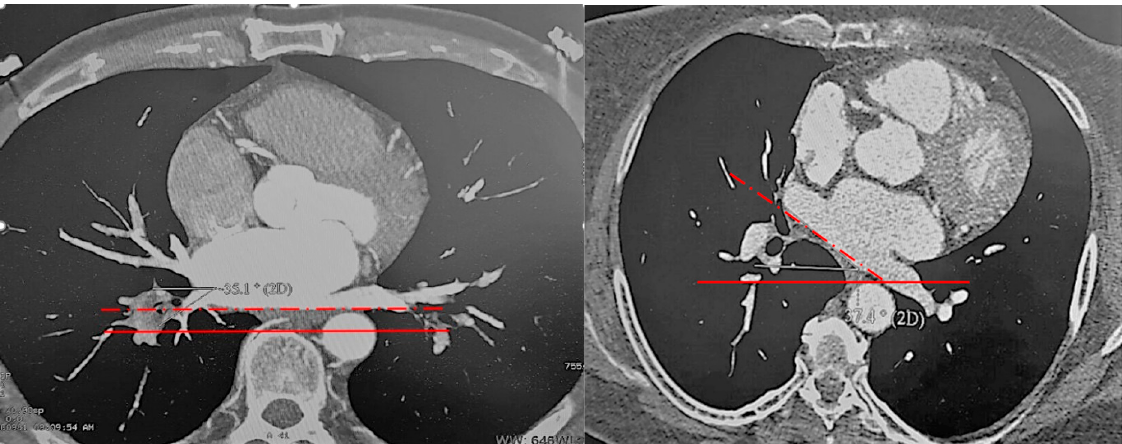
Figure 2. Spatial orientation of the LA posterior wall: red lines—frontal plane; red dot lines—LA posterior wall orientation.